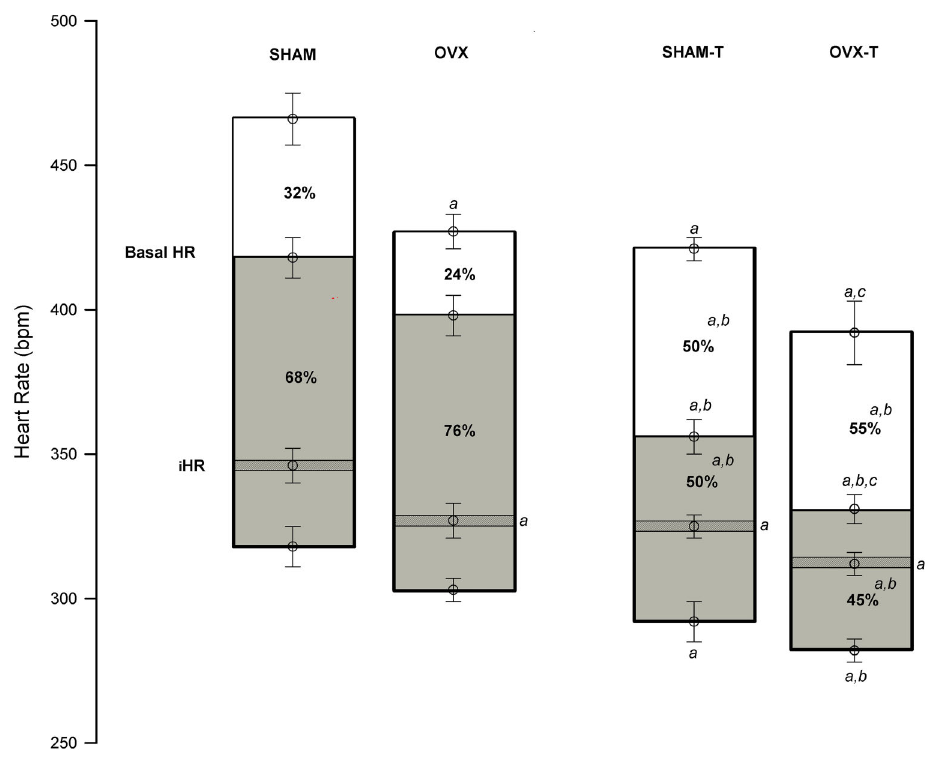
Figure 3. The bar graphs show the delta ( D ) of heart rate (HR) after methylatropine (white box) and propranolol (gray box) injection in the SHAM and ovariectomized (OVX) groups of sedentary (SHAM and OVX) and trained (SHAM-T and OVX-T) animals. All data are reported as means ± SE. a P o 0.05 vs SHAM; b P o 0.05 vs OVX; c P o 0.05 vs SHAM-T (ANOVA). iHR: intrinsic